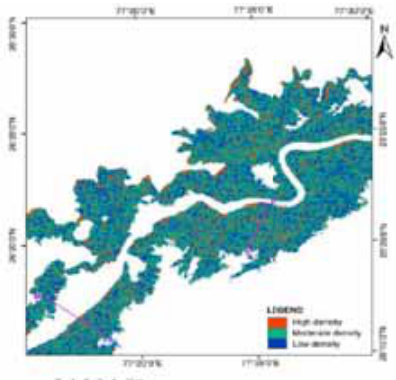
Fig. 3: Ravine density classes in information of the speckle-su image. (A_B and C_D are the along which ground truths on th 100 m regular interval.)